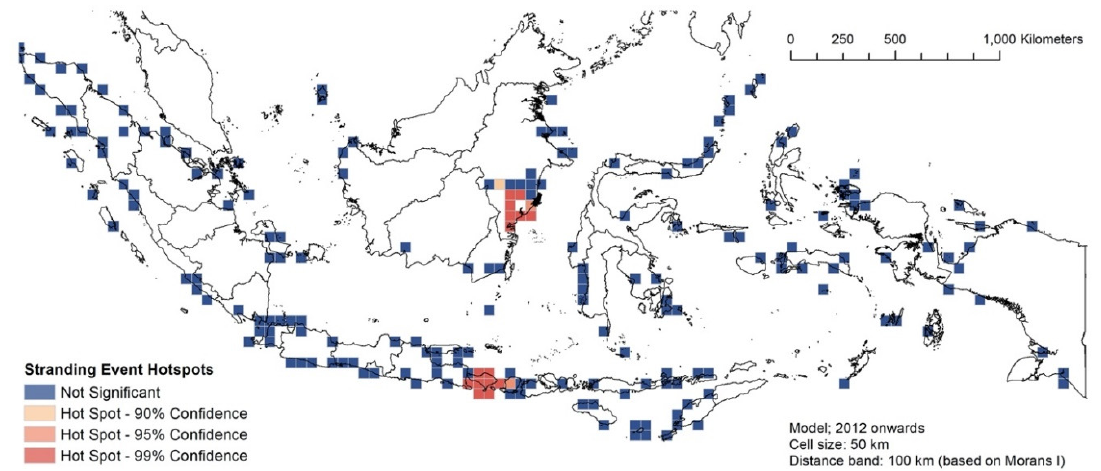
Figure 9. The spatial hotspot analysis of single stranding events of 2012–2021.